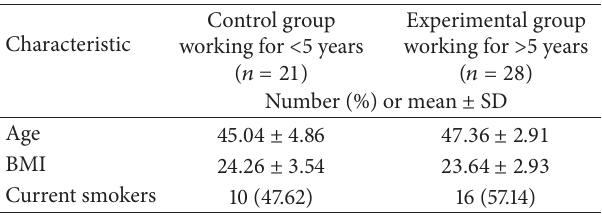
Table 2: Characteristics of the study subjects.